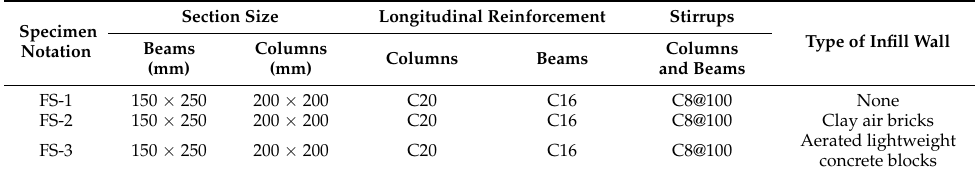
Table 1. Basic information of specimens.